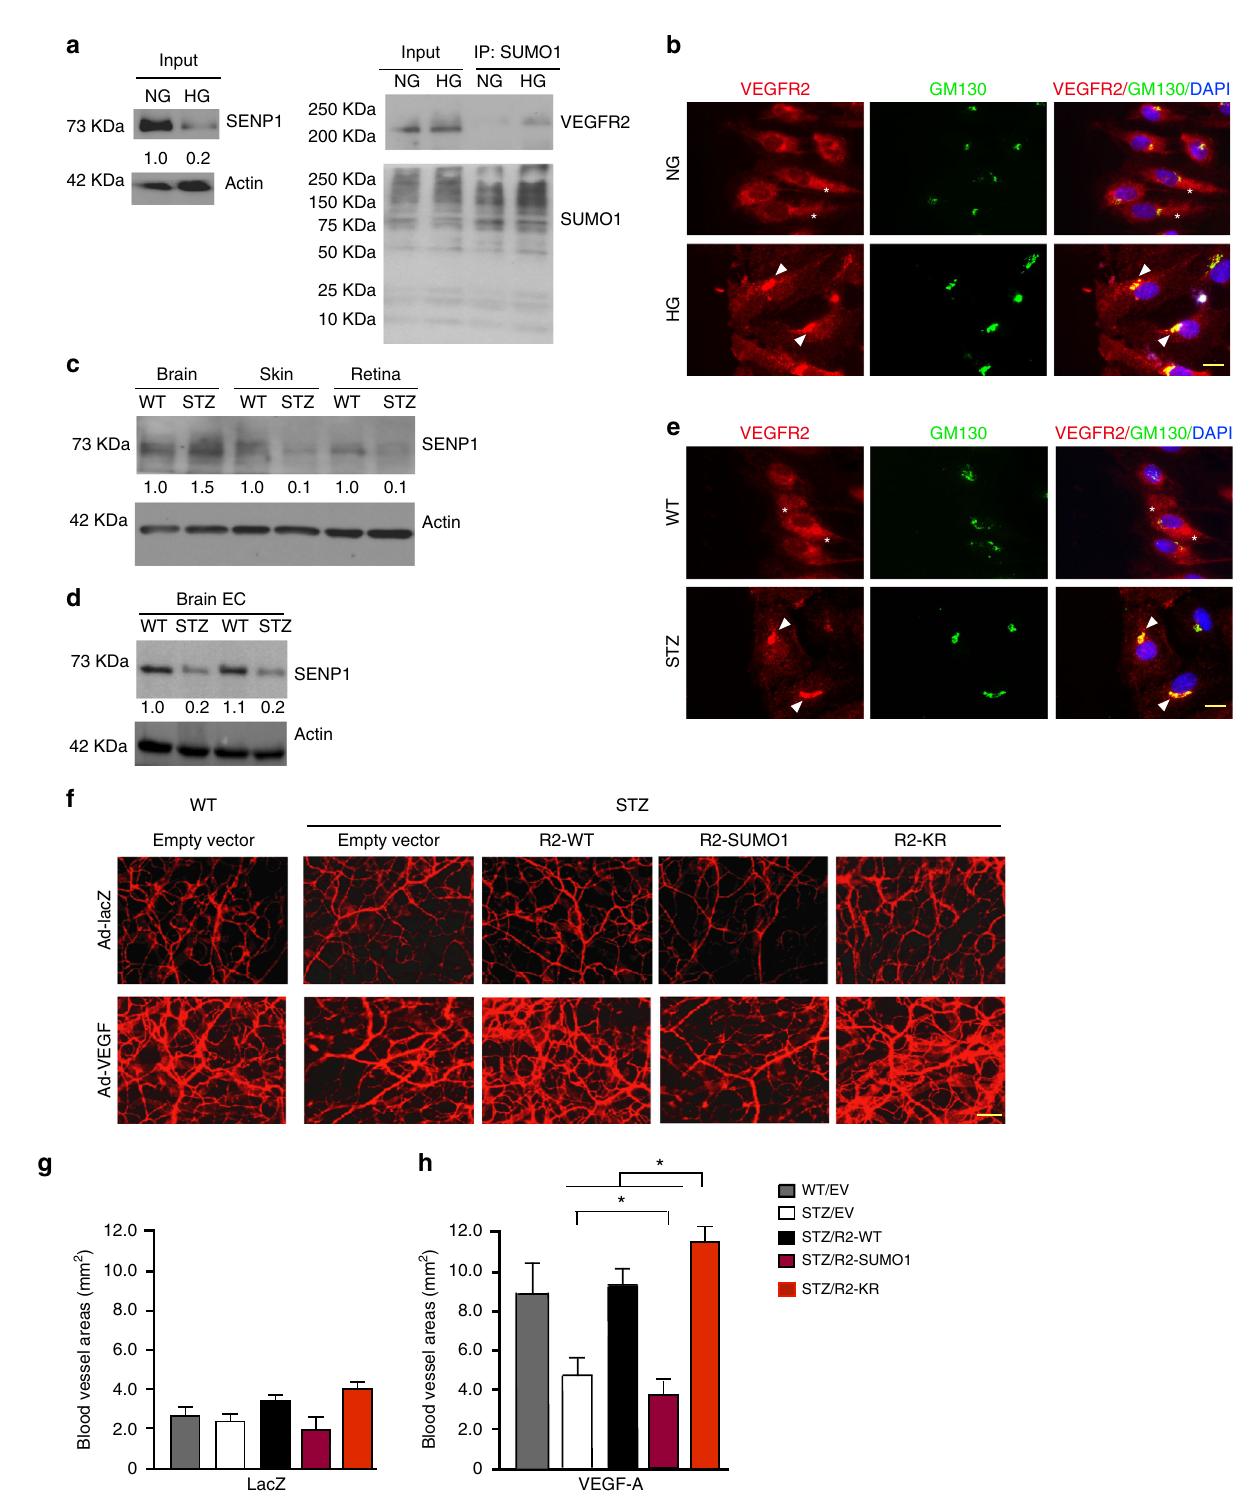
Fig. 7 The SENP1-VEGFR2 signalling in diabetic angiogenesis. a , b HUVEC were cultured under 5 mM or 25 mM glucose for 72 h. Expression of SENP1 and VEGFR2 SUMOylation were determined ( a ). VEGFR2 localisation was determined by indirect immuno fl uorescence for VEGFR2 and GM130 ( b ). c Tissues from WT and STZ mice were harvested. SENP1 expression in brain (whole lysates), retina and ear skin (the vascular layer) was determined by western blot with anti-SENP1. d SENP1 expression in MBMVEC isolated from WT and STZ mice. Protein bands in ( c , d ) were quanti fi ed by densitometry and fold changes are presented by taking WT group as 1.0. n = 2. e VEGFR2 localisation in MBMVEC isolated from WT and STZ mice was determined by indirect immuno fl uorescence for VEGFR2 and GM130. f – h Adenovirus encoding VEGF 164 (1 × 10 9 pfu) (Ad-VEGF) or β -galactosidase (Ad-LacZ) was co-injected with empty vector, VEGFR2-WT, VEGFR2-SUMO1 or VEGFR2-K1270R intradermally into ear skin of SENP1-ECKO mice. VEGF-induced angiogenesis in WT and SENP1-ECKO mice was accessed by a whole-mount staining with anti-CD31 antibody. Vascular density was quanti fi ed and data are mean ± SEM from ten fi elds per mouse ear. ( n = 5 for each group). Error bars, mean ± SEM; * P < 0.05, one-way ANOVA. Scale bar: 20 μ m ( b ); 100 μ m ( f